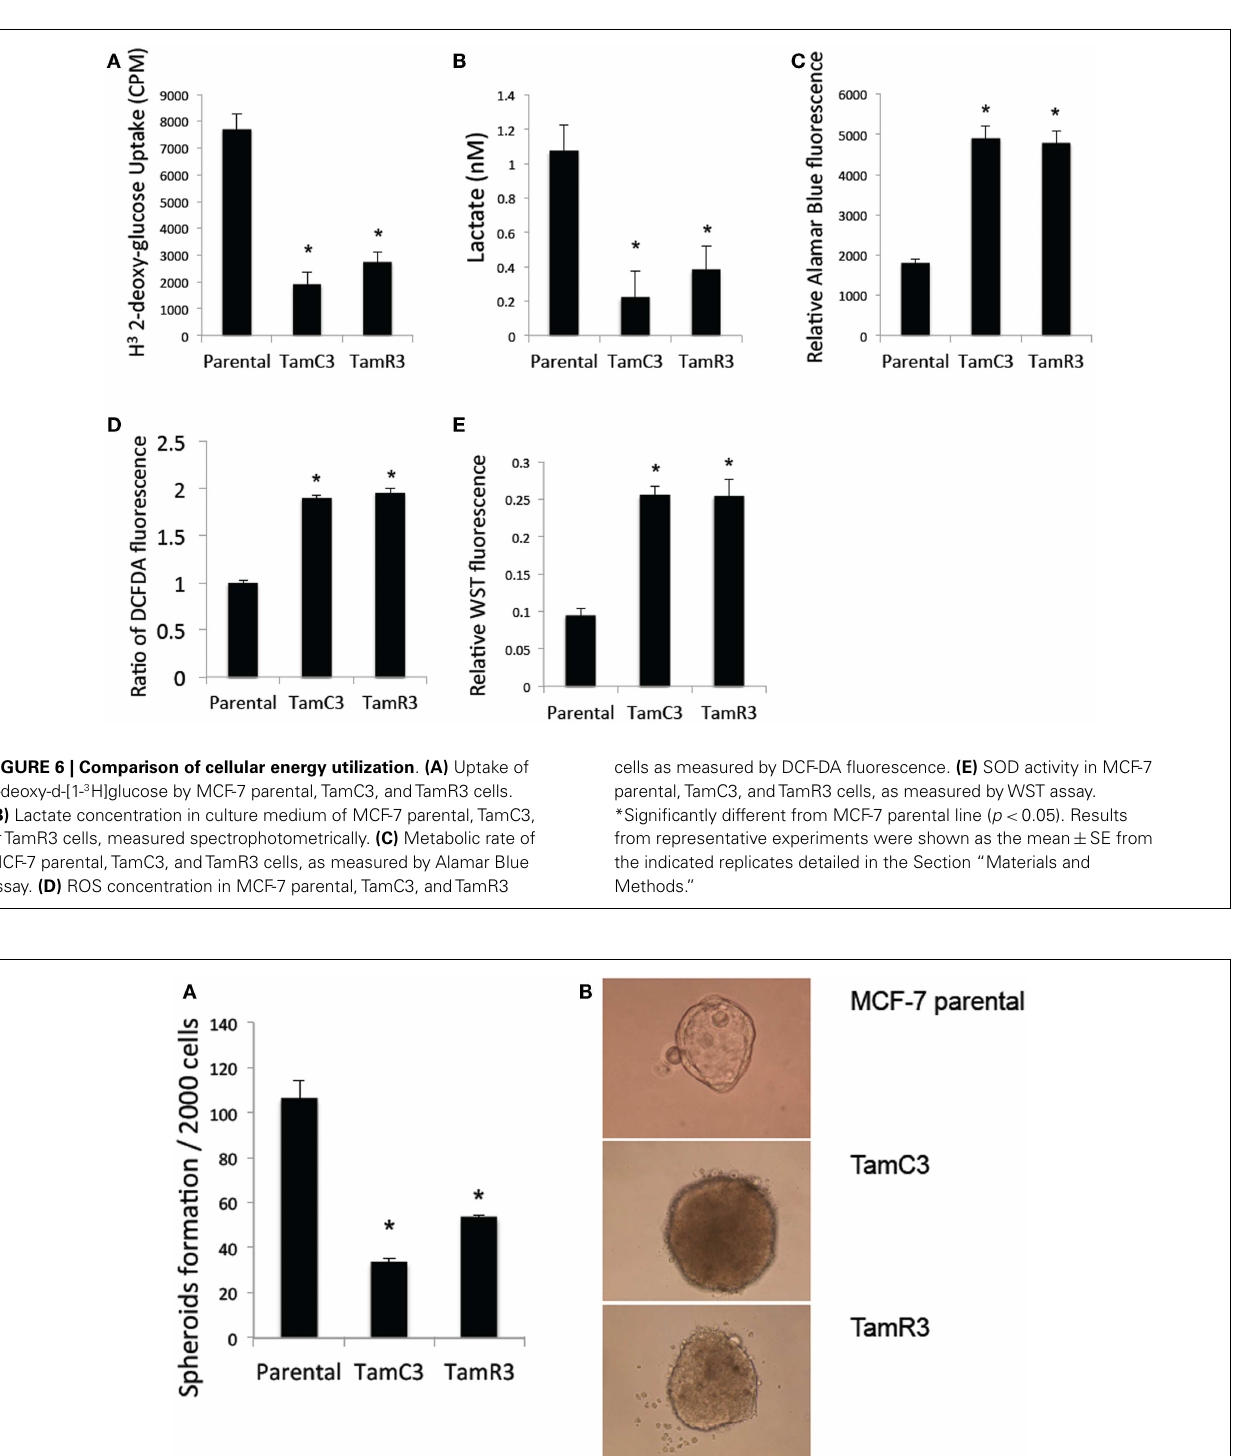
FIGURE 7 | Mammospheres formation in MCF-7 parental,TamC3, andTamR3 cells . (A) Mammosphere formation efficiency in MCF-7 parental,TamC3, and TamR3 cells. (B) Mammospheres morphology of MCF-7 parental (ascini),TamC3, andTamR3 cells (compact spheroid). *Significantly different from MCF-7 parental line ( p <